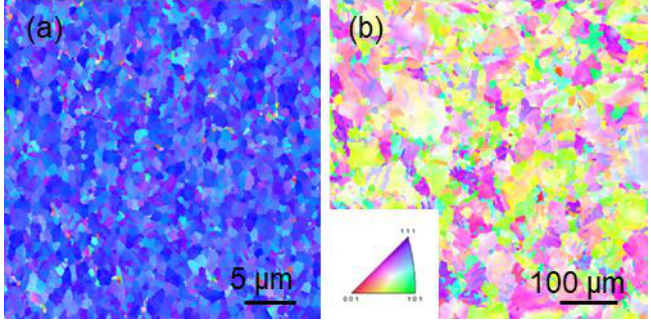
Figure 6. The grain orientation image maps of ( a ) <111>-oriented nt-Cu, and ( b ) <110>-oriented mt-Cu after annealing at 250 °C for 10 min.